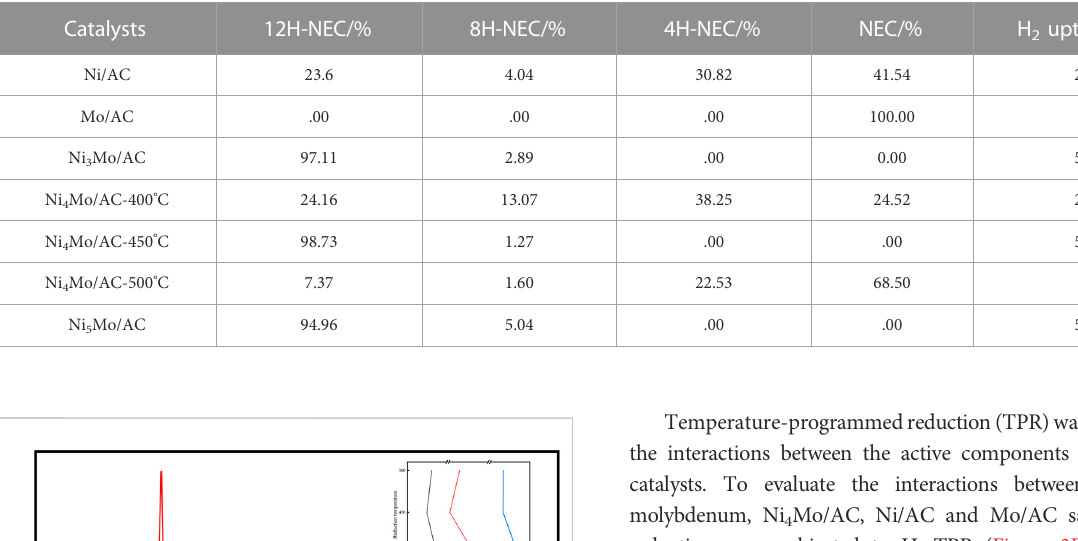
TABLE 2 Hydrogenation activities of different catalysts.